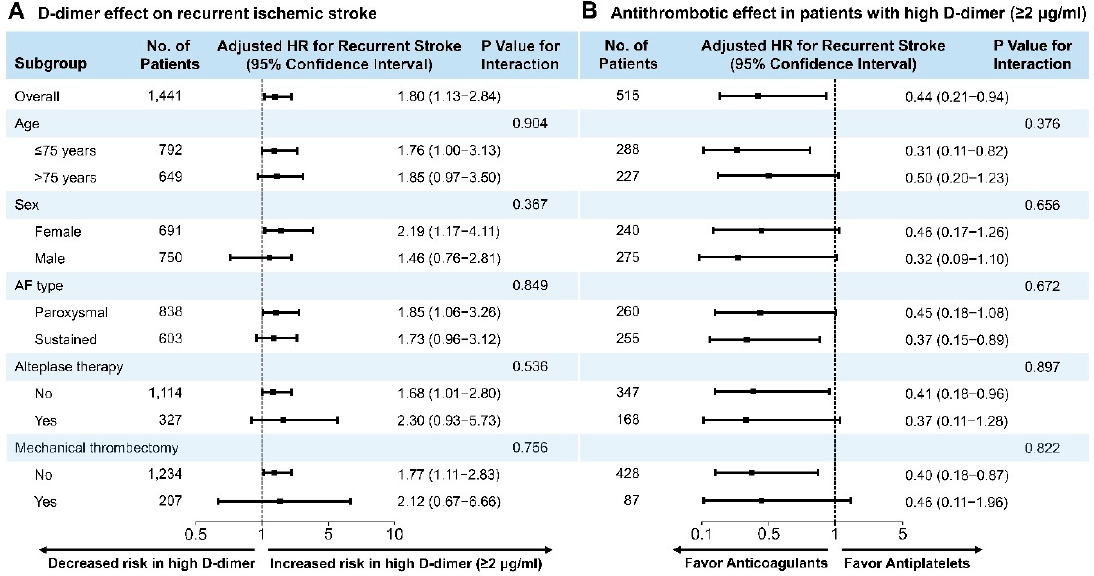
Figure 7. Subgroup analyses of recurrent stroke. The forest plot shows the differences in hazards ratio for high D-dimer levels ( ≥ 2.0 μ g/mL) in all patients with combined AF and atherosclerosis ( A ) and a comparison between anticoagulant and antiplatelet therapy in patients with D-dimer levels ≥ 2.0 μ g/mL ( B ). AF, atrial fibrillation.